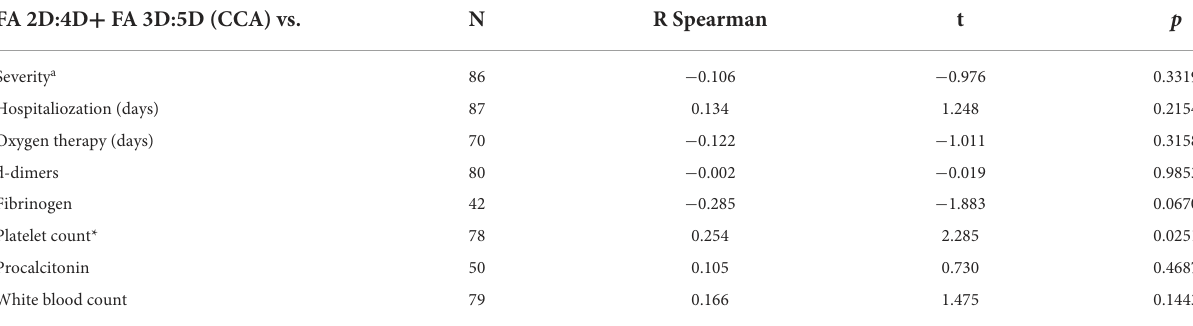
TABLE 6 Spearman correlation coefficients for 2D:4D plus 3D:5D FAs and clinical parameters in patients with COVID-19. FA 2D:4D + FA 3D:5D (CCA)